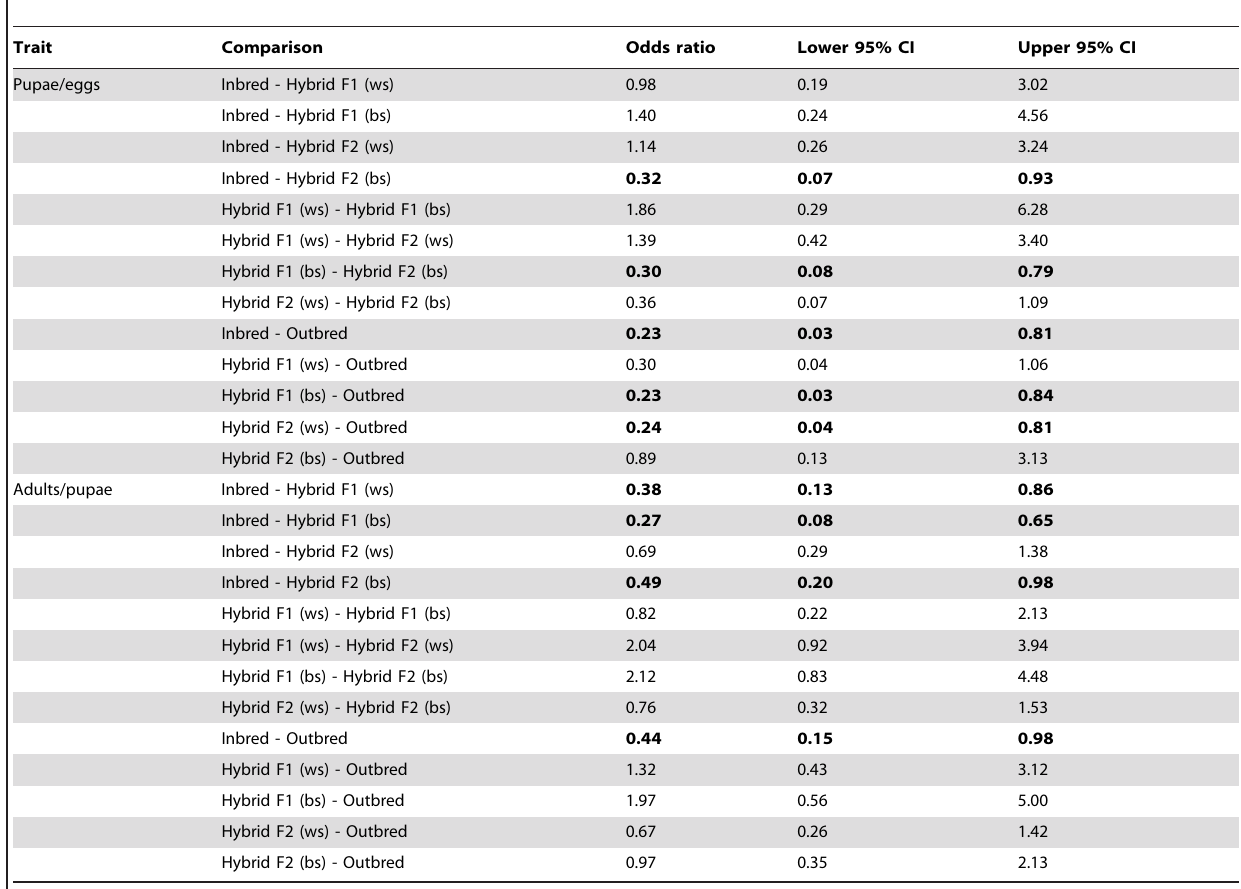
Table 3. Pairwise odds ratios (effect size and 95% credible intervals) for proportion of eggs that pupated and proportion of pupae that eclosed for inbred, hybrid, and outbred groups of Drosophila melanogaster (ws: within-strain crosses, bs: between-strain